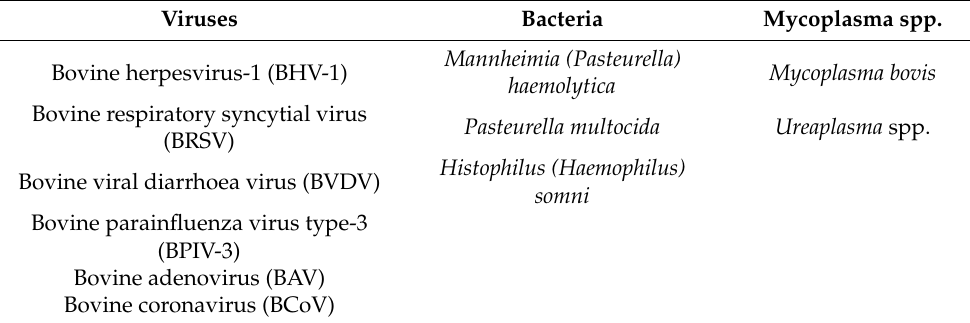
Table 1. Common viral and bacterial pathogens implicated in